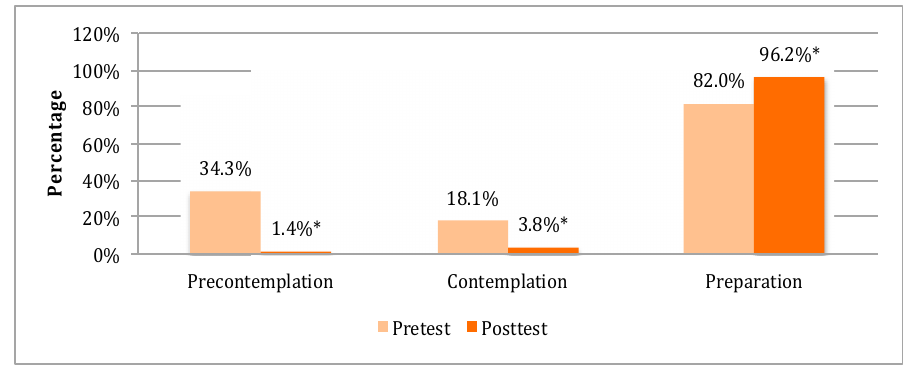
Figure 1. Distribution of respondents by Stages of Change at pre- and post-test ( n = 210 for pre-contemplation; n = 133 for contemplation and preparation). * Denotes significance at 1% level.